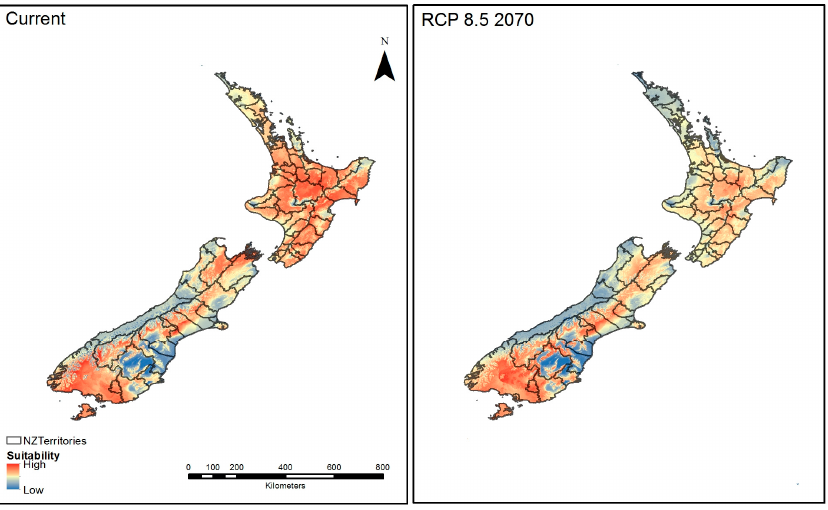
Figure 7. Ensembled suitability mapped into the official territories of New Zealand for: current conditions ( left ); and future climatic conditions ( right ), for Representative Concentration Pathways (RCP) 8.5 year 2070.